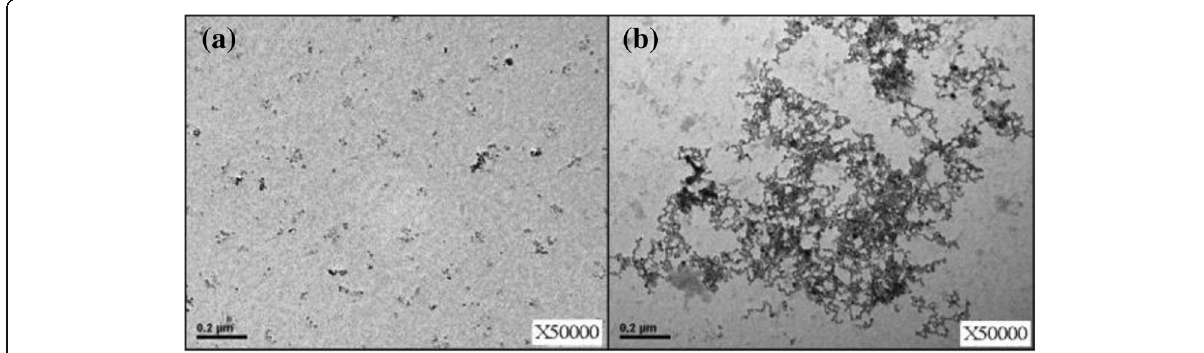
Fig. 6 Silver nanoparticles at 50,000X magnification ( a ) without Ni 2+ and ( b ) with Ni 2+ showing intense